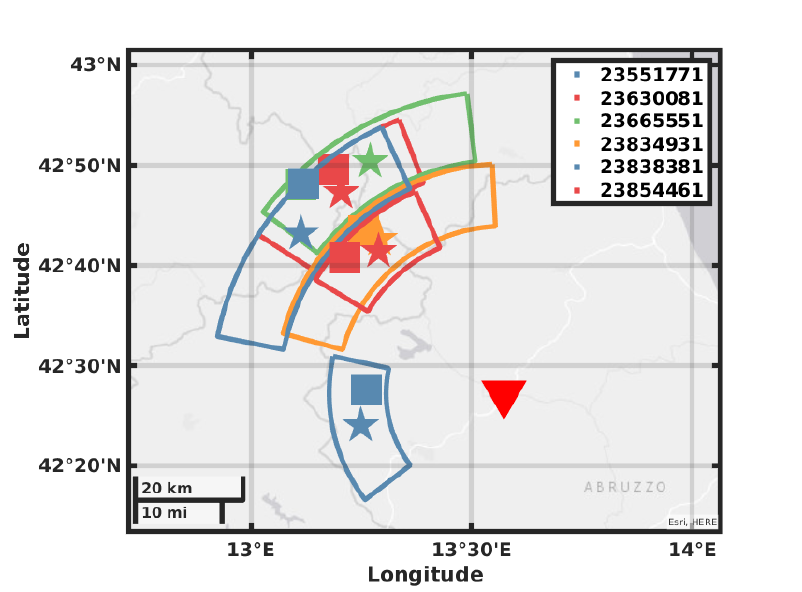
Figure 11. Map showing the GIGS station location, the earthquakes located by the INGV in solid squares, the earthquakes located using the GIGS station and the relative location error in polar